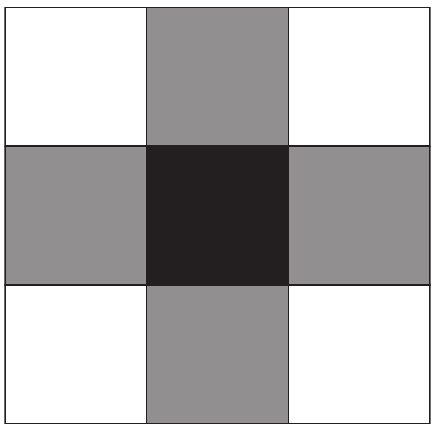
Figure 2: Four neighborhoods of a point. The four gray points are neighborhoods of the black